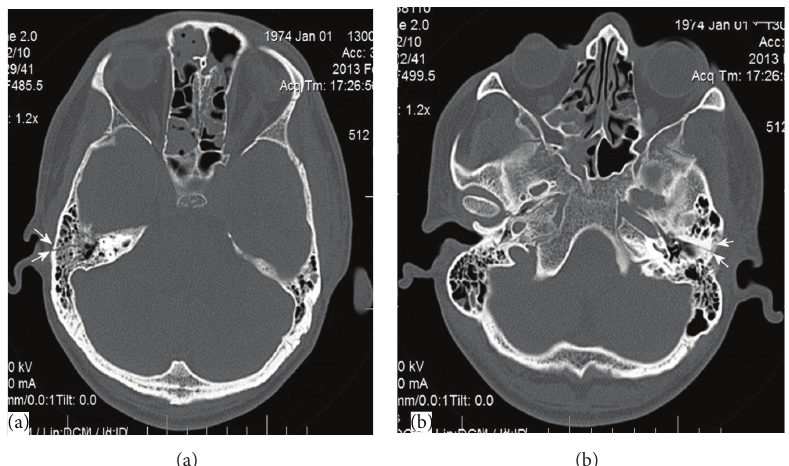
Figure 1: A CT scan performed on admission, showing a right transverse temporal fracture (a) and a left transverse temporal fracture (b).